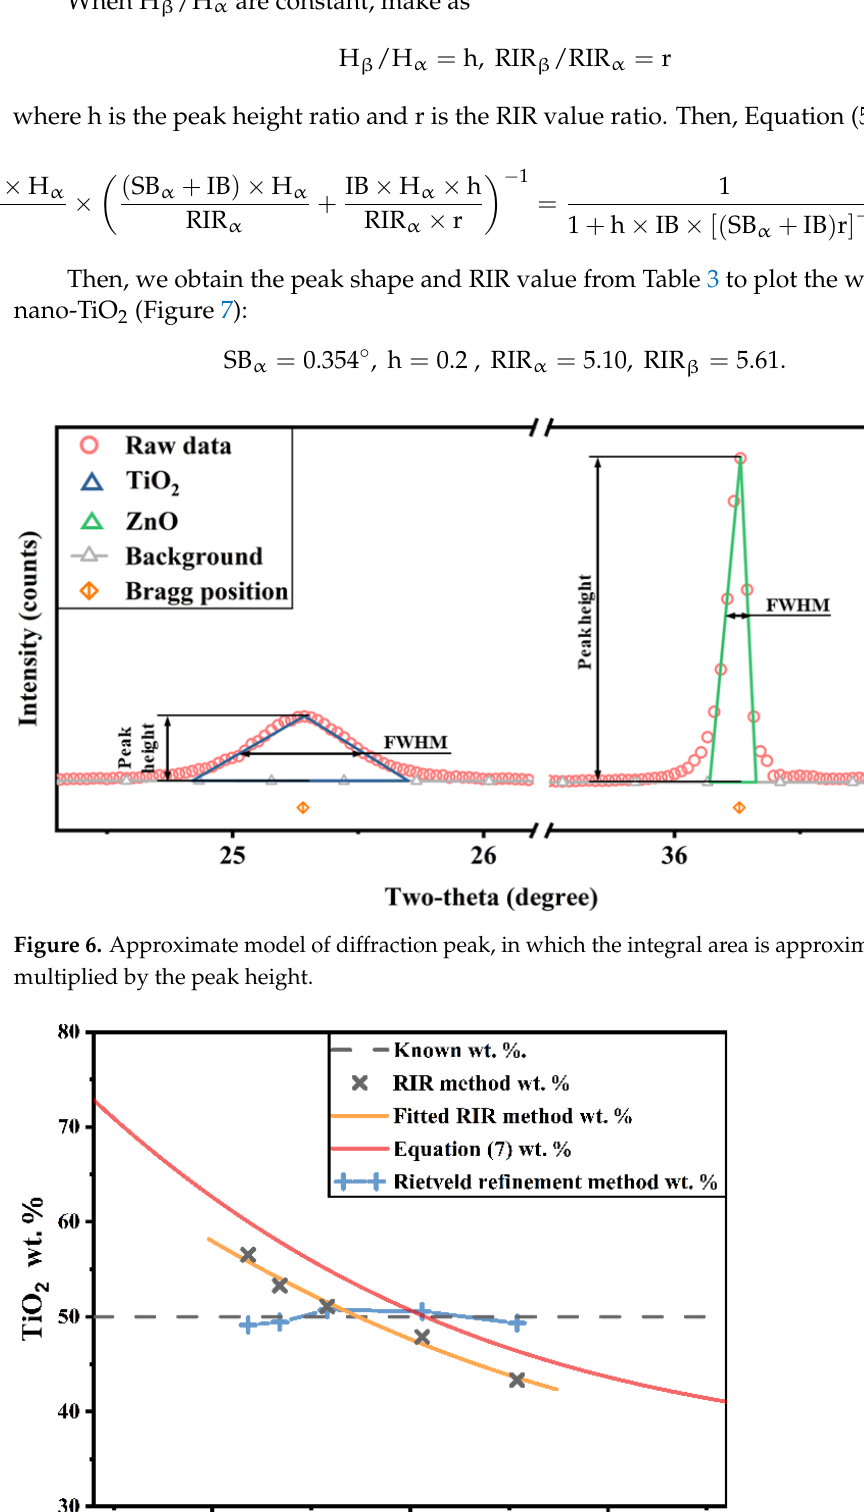
Figure 7. Nano-TiO 2 quantitative curve based on Equation (7), which are compared to known wt.%, experimental wt.% and Rietveld refinement wt.%. The quantitative deviation of RIR method can be explained by the simplification of Equation (7):